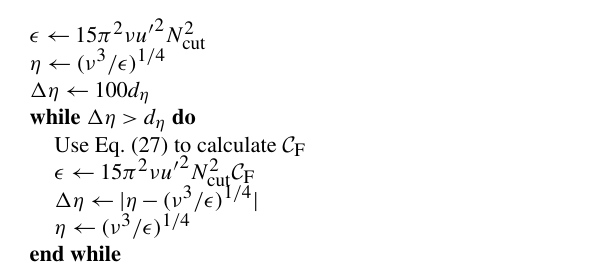
Figure 2. (a) Frequency spectrum of the measured signal (POST); (b) second order structure function. The polynomial fit is presented as a colored dashed